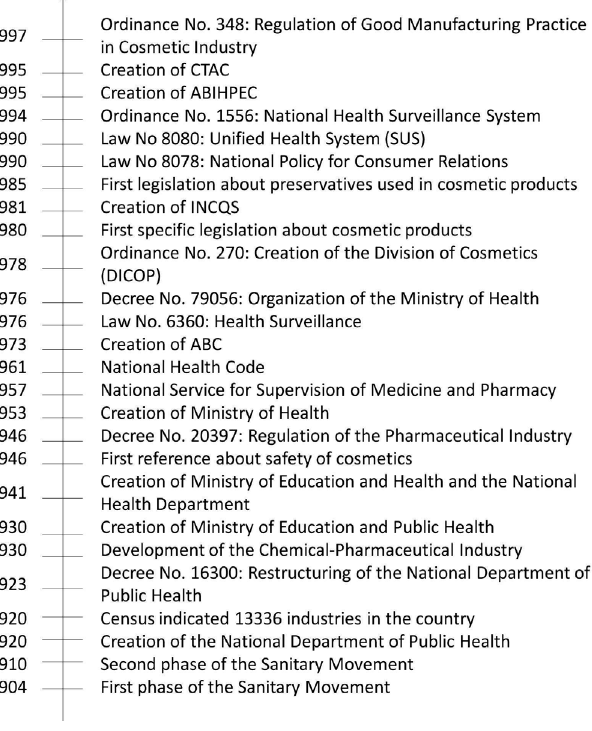
FIGURE 1 - Overview of the regulatory milestones in the 20th century before